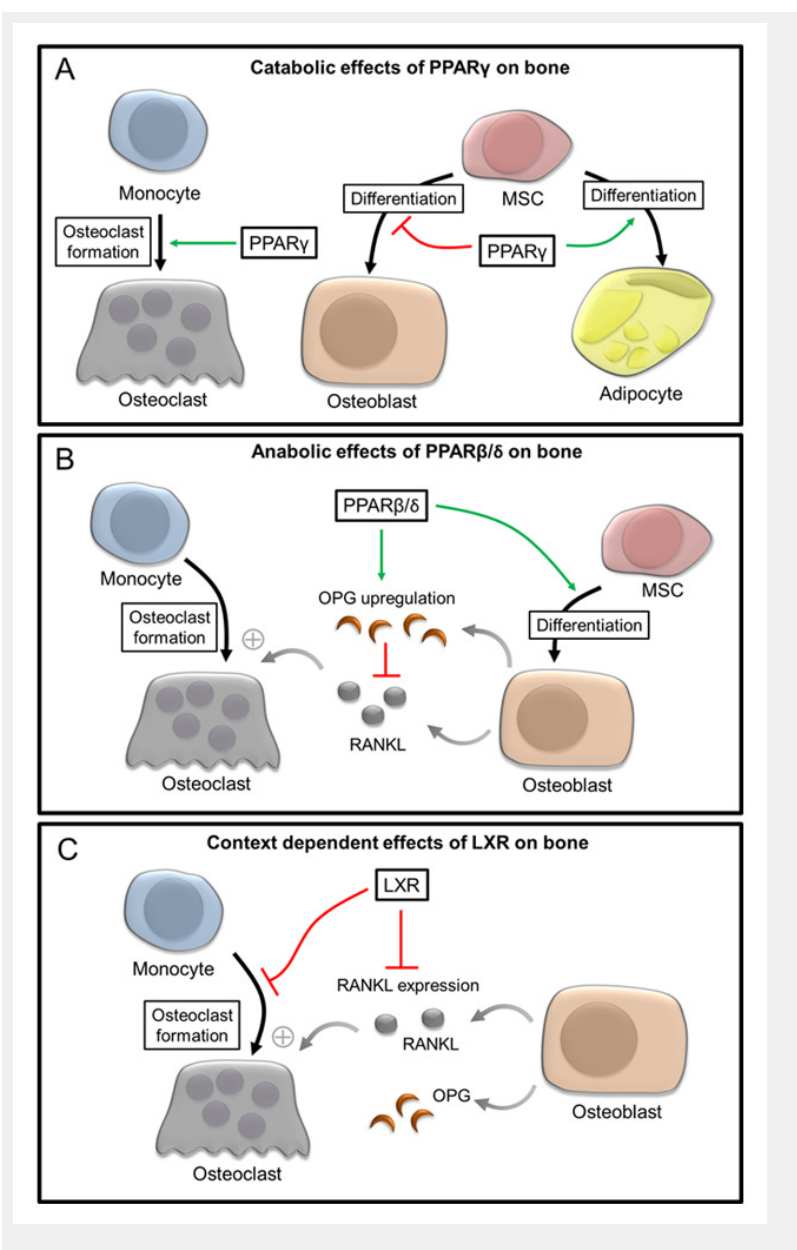
Figure 2 Role of PPARγ, PPARβ/δ and LXRs during the control of osteoblast and osteoclast differentiation. (A) Catabolic effects of PPARγ on bone homeostasis are attributed to the PPARγ-mediated promotion of osteoclast differentiation and its inhibitory role during the differentiation of mesenchymal stem cells (MSC) into osteoblasts. (B) PPARβ/δ exert its anabolic effects on bone homeostasis via promotion of the osteoblast differentiation and regulation of the RANKL/OPG ratio thereby indirectly influencing osteoclastogenesis. (C) During states of increased osteoclastogenesis and high bone turnover such as inflammation and osteoporosis, activation of LXRs is able to both directly and indirectly interfere with osteoclast differentiation via blockade of osteoclastogenesis and influencing the RANKL/OPG